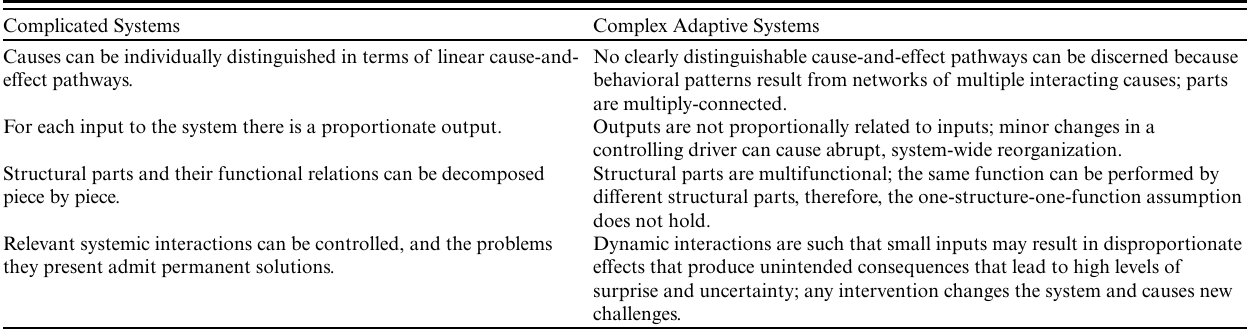
Table 3 . Differences between complicated systems and complex adaptive systems (based on Poli 2013). Complicated Systems Complex Adaptive